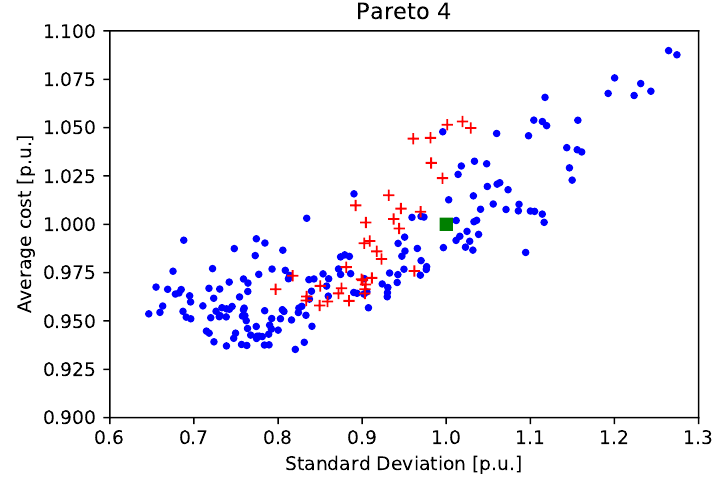
Figure 10. Performance points for alternative 4 (blue dots) and Alternative 8 (red crosses). Deterministic solution in green